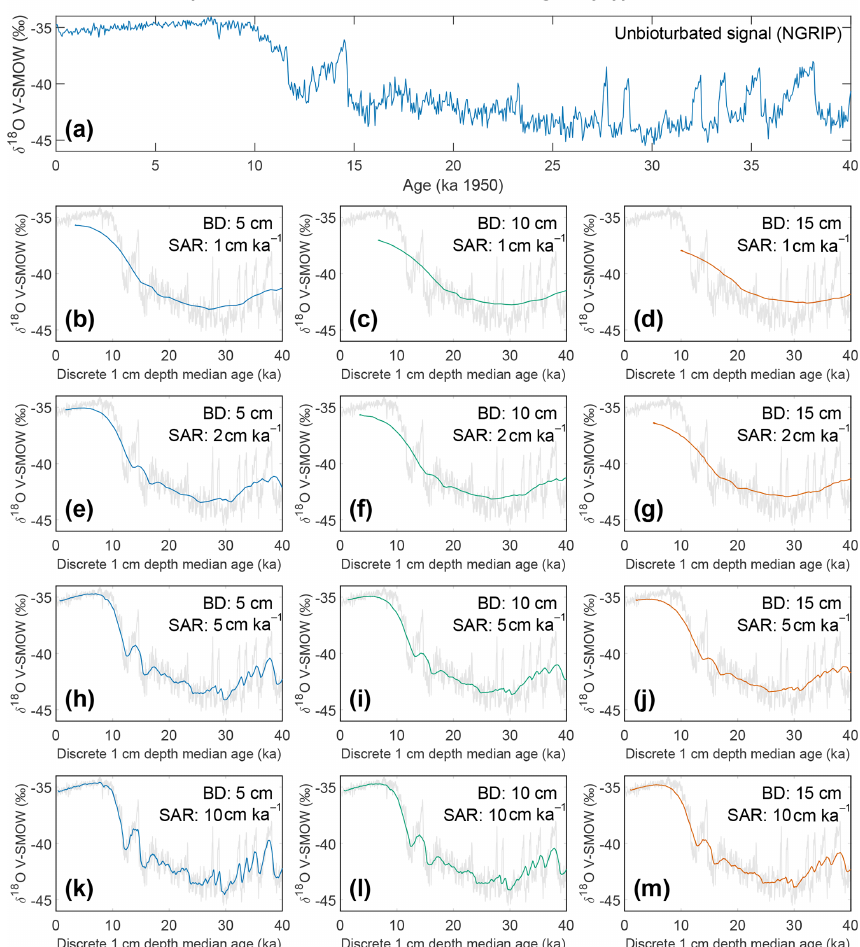
Figure 8. Output of the bioturbation model SEAMUS. (a) The unbioturbated input signal, NGRIP (North Greenland Ice Core Project Mem- bers, 2004; Rasmussen et al., 2014; Seierstad et al., 2014), used in our simulation of bioturbation for different SAR with SEAMUS (Lougheed, 2020b). Sediment mixed layer referred to here as bioturbation depth (BD) is fixed at (b, e, h, k) 5cm, (c, f, i, l) 10cm, and (d, g, j, m) 15cm for sedimentation accumulation rates (SAR) of (b–d) 1cmkyr − 1 , (e–g) 2cmkyr − 1 , (h–j) 5cmkyr − 1 , and (k–m) 10cmkyr − 1 . The output is plotted as the discrete 1cm depth median age. In (b) – (m) grey values represent the unbioturbated input signal, NGRIP. Note, we retain the original units (V-SMOW) of the original time series used; no inference between Pacific climate and Greenland is intended by the use of